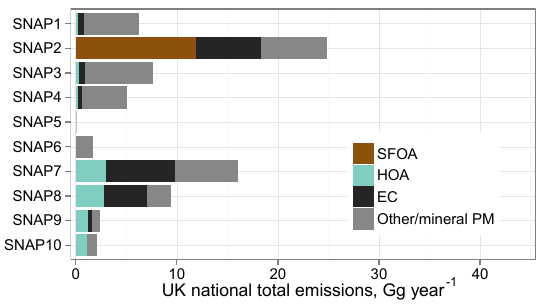
Table 1. SNAP source sectors as specified in the emissions input to the model (CEIP, 2015).